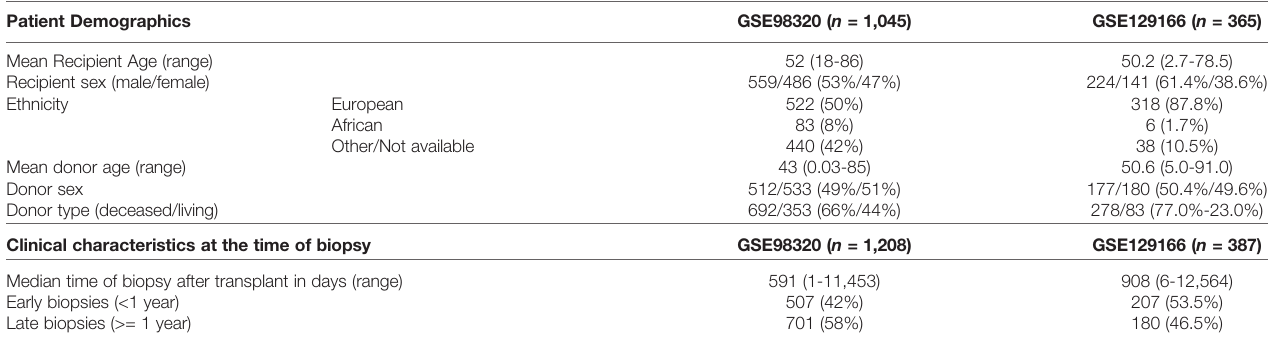
TABLE 2 | Demographics and clinical characteristics GSE data sets.